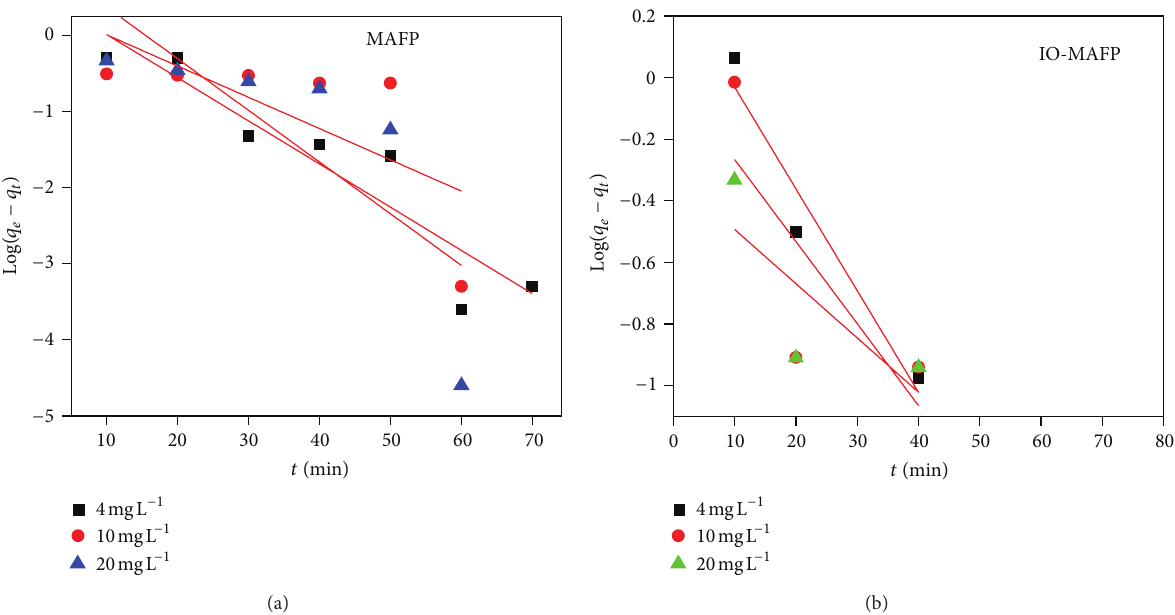
Figure 9: Pseudo-first order for Co(II) biosorption onto MAFP and IO-MAFP biomasses.